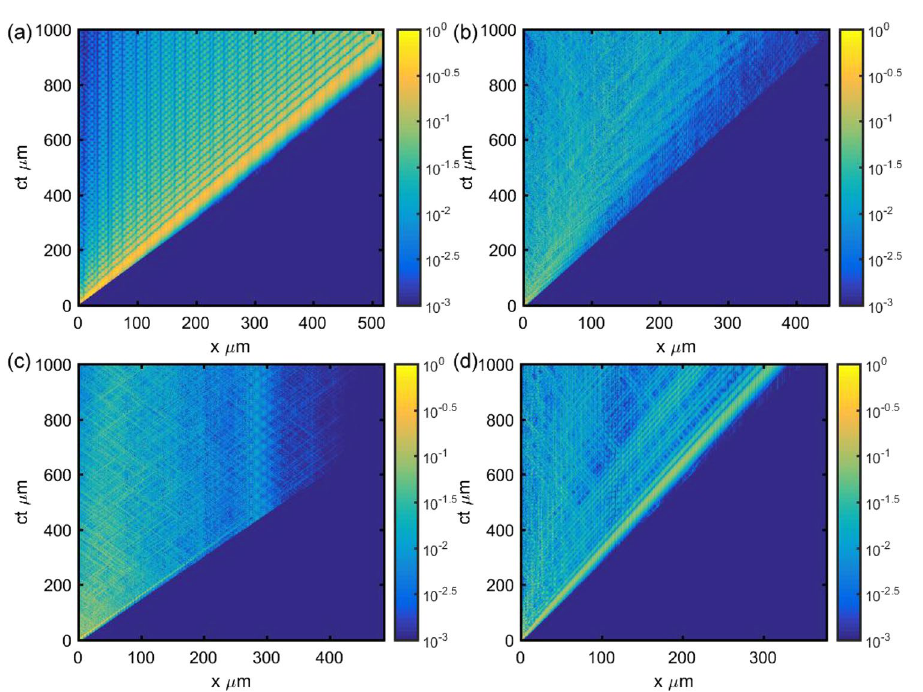
Figure 8. Time evolution of optical pulse in different sequence of layers. ( a ) Periodic micro cavities ( n 1 = 1.5 and n 2 = 1.65; 207 Layers), ( b ) Fibonacci ( n 1 = 1.5 and n 2 = 2.5; 233 Layers), ( c ) Rudin-Shapiro ( n 1 = 1.5 and n 2 = 1.7; 256 Layers) and ( d ) Thue-Morse ( n 1 = 1.5 and n 2 = 3.5; 256 Layers). Color represents ψ x t ( , ) calculated using equation (10). ‘ct’ in all panels is the time equivalent length where c represents the velocity of light in vacuum and t represents